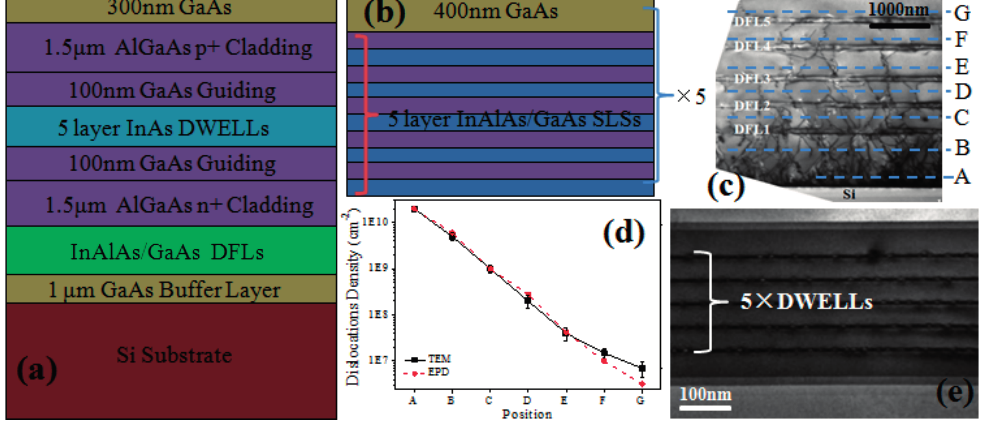
Figure 1. ( a ) Schematic of the layer structure. ( b ) Schematic of the InAlAs/GaAs dislocation filter layers (DFLs). ( c ) Cross-sectional TEM image of InAlAs/GaAs DFLs. ( d ) Changes in dislocation density, determined by TEM and etch-pit defects (EPD), counted at different positions labeled in Figure 1c. ( e ) Cross-sectional TEM image of the active